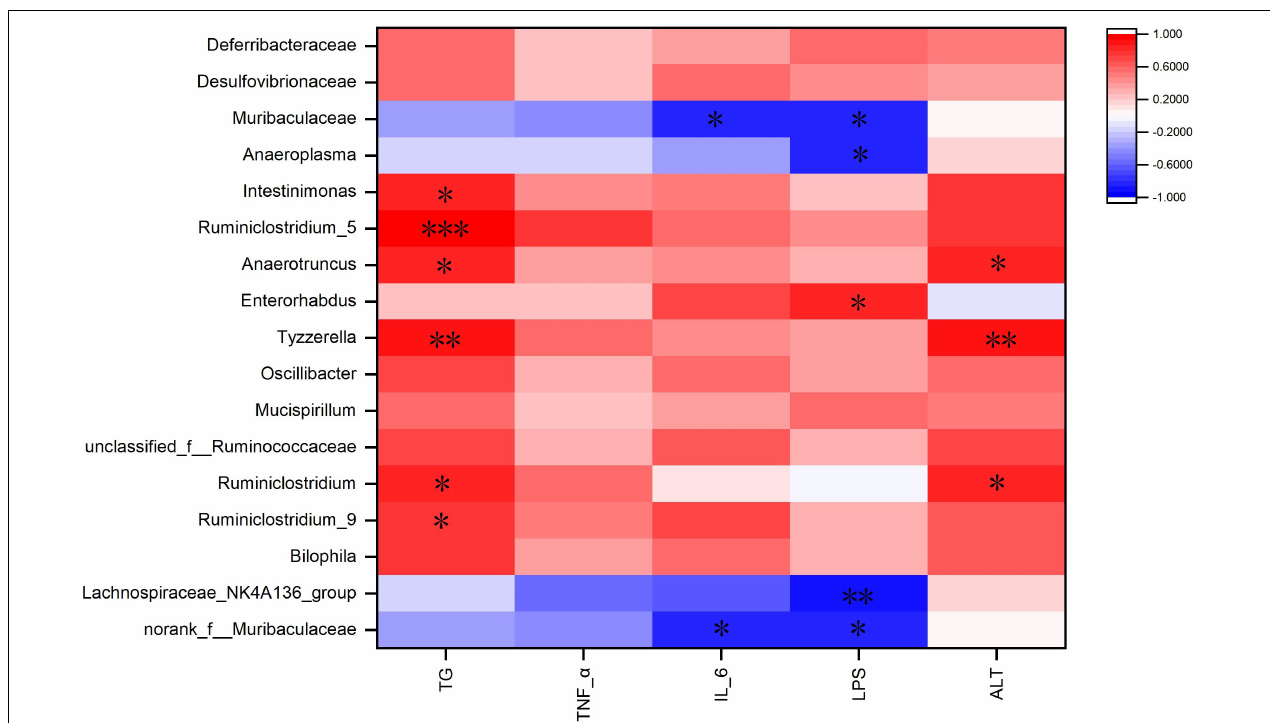
FIGURE 8 | Heatmap of Spearman’s correlation between the gut microbiota and obesity-related indices. The intensity of the colors represented the degree of association (red, positive correlation; blue, negative correlation). Significant correlations are marked by * P < 0.05; ** P < 0.01; *** P < 0.001.